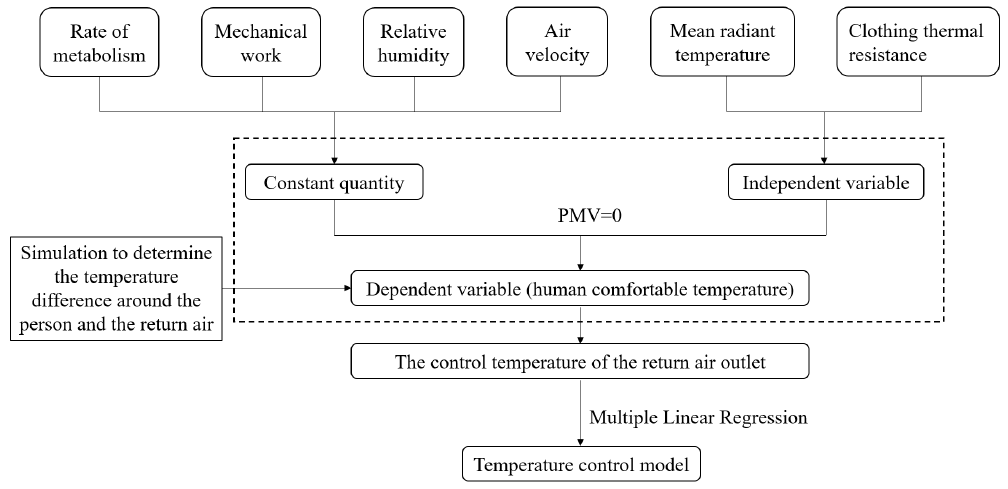
Figure 6. The research method for the temperature-control model of the subway train.